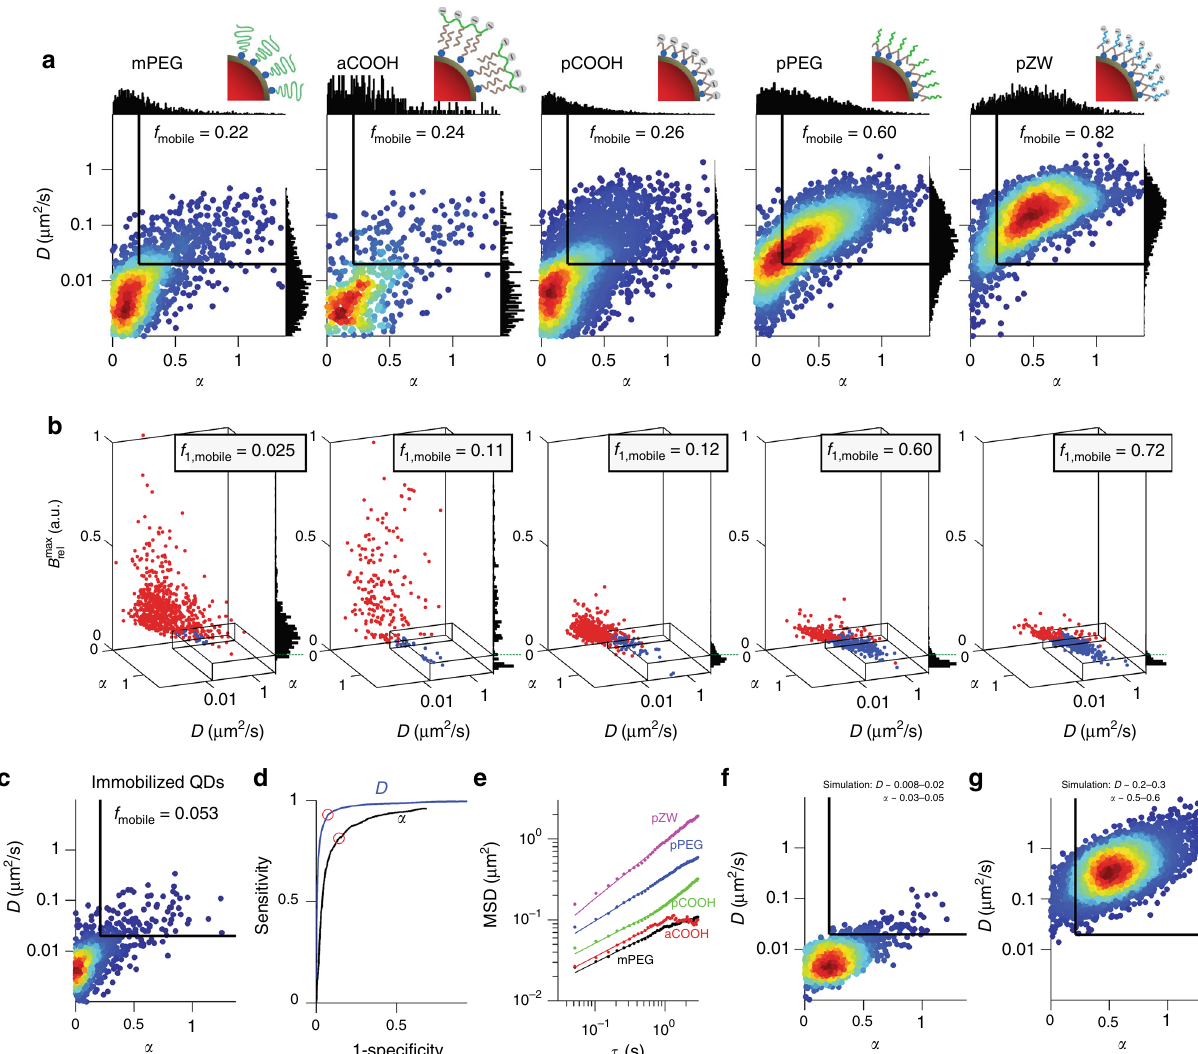
Fig. 4 Coating-dependent behavior of intracellular quantum dots. a Heat maps of diffusion coef fi cient, D , versus con fi nement parameter, α . Histograms of D and α are projected on the x and y axes, respectively, and thresholds imposed for mobility are shown as black lines, yielding f mobile shown in each plot. n = 7, 7, 16, 11, and 18 CHO cells for mPEG, aCOOH, pCOOH, pPEG, and pZW, respectively. b Representative 3D plots of D versus α versus B max different quantum dot (QD) coatings in individual cells. The box indicates the same threshold from a , in addition to a B max populations of single QDs to determine f 1,mobile , shown in the inset of each plot. c Heat map of D versus α for immobilized QDs. d Receiver operating characteristic (ROC) curves distinguishing immobilized QDs from pZW-coated QDs in CHO cells, independently for D (blue) and α (black). Cutoffs that maximize both sensitivity and speci fi city ( D > 0.020 μ m 2 s − 1 and α > 0.21) are marked by red circles. e Ensemble average MSD plot for all recorded Table 1. f Heat map of D versus α for simulated trajectories generated using D and α inputs across the indicated ranges to approximate the mPEG-QD distribution. g Heat map of D versus α for simulated trajectories generated using D and α inputs across the indicated ranges to approximate the pZW